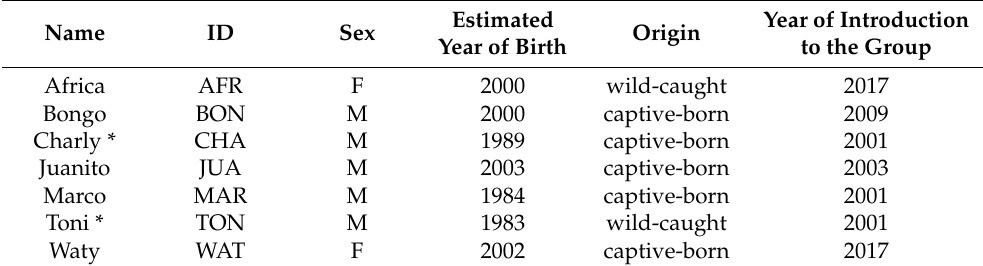
Table 1. Individuals’ characteristics and background information.